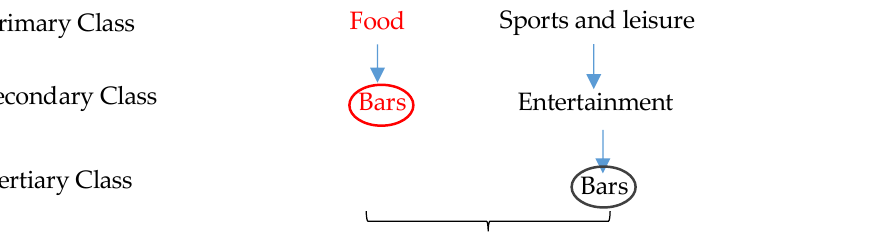
Figure 2. The same POIs with a low class similarity.